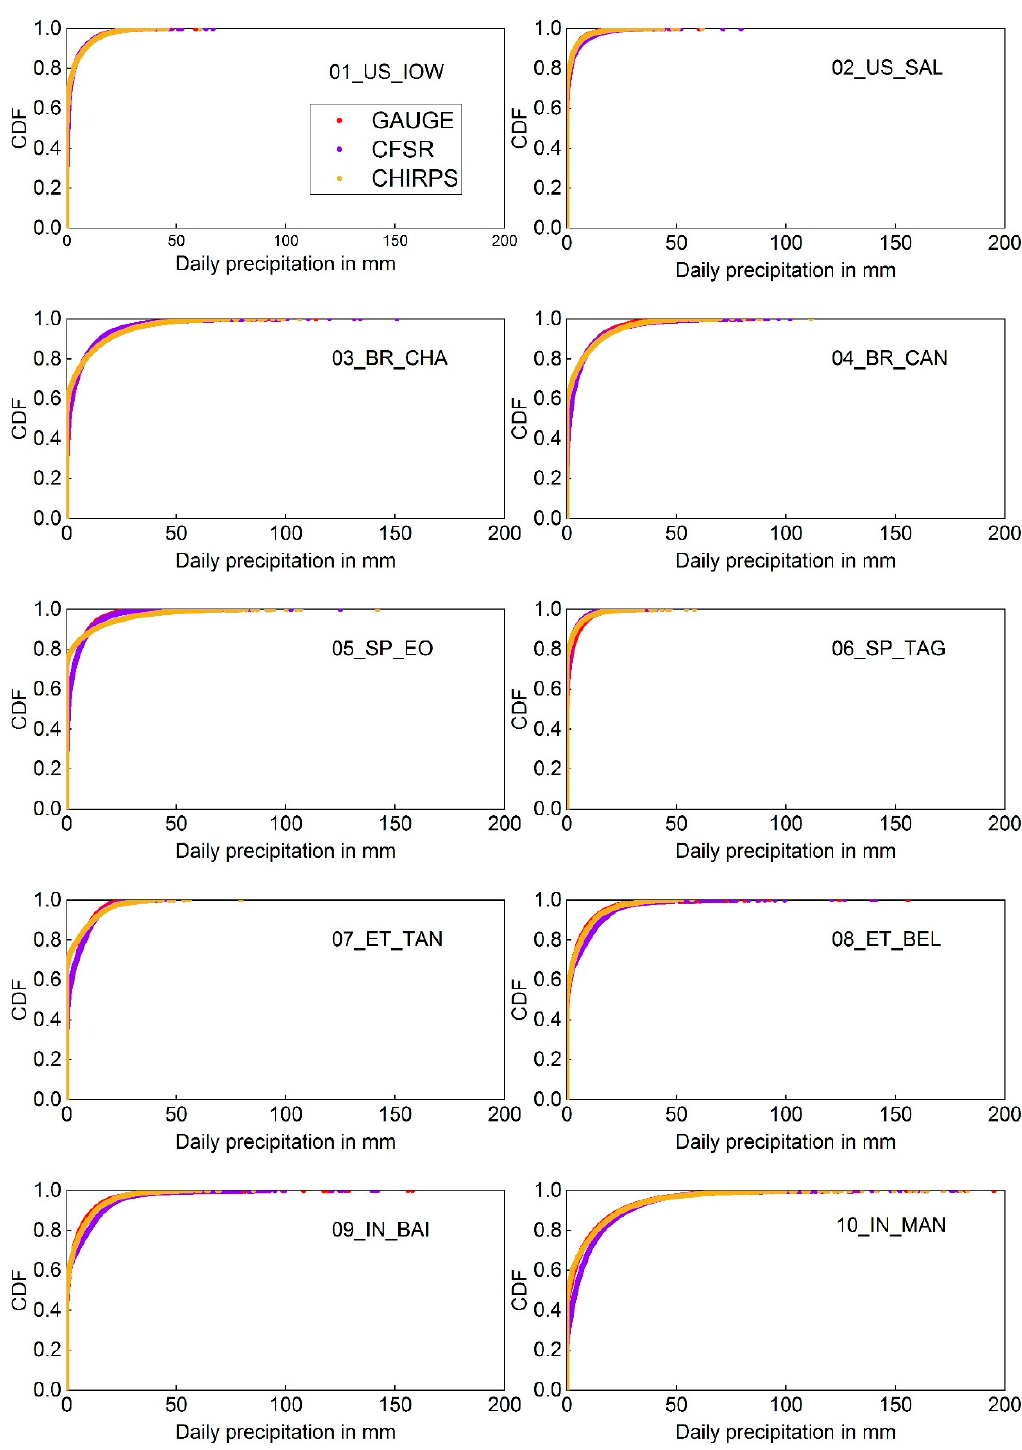
Figure 5. Cumulative distribution of daily rainfall of the selected watersheds for 1. Gauge 2. CFSR, and 3.